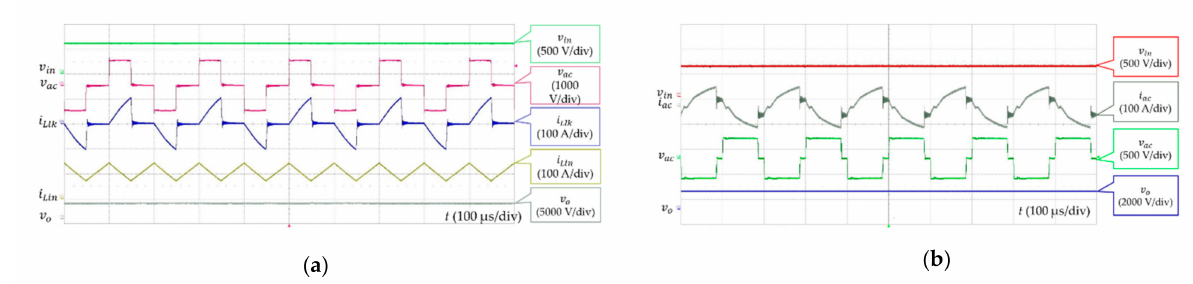
Figure 17. Experimental waveforms of DC module in two modes. ( a ) Step-up mode; ( b ) Step-down mode.